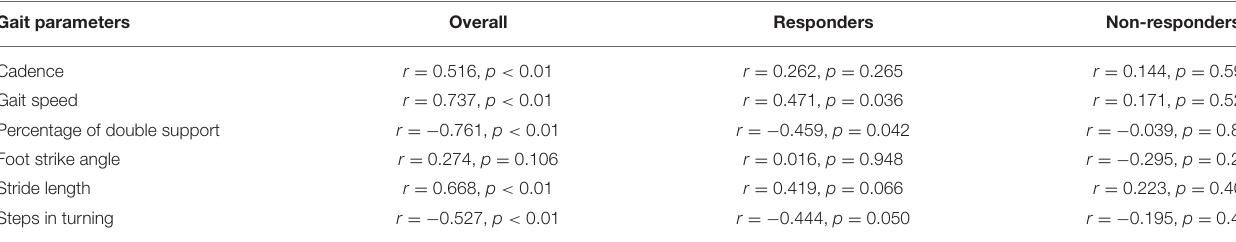
TABLE 4 | Correlations between gait parameter change values and global rating of change